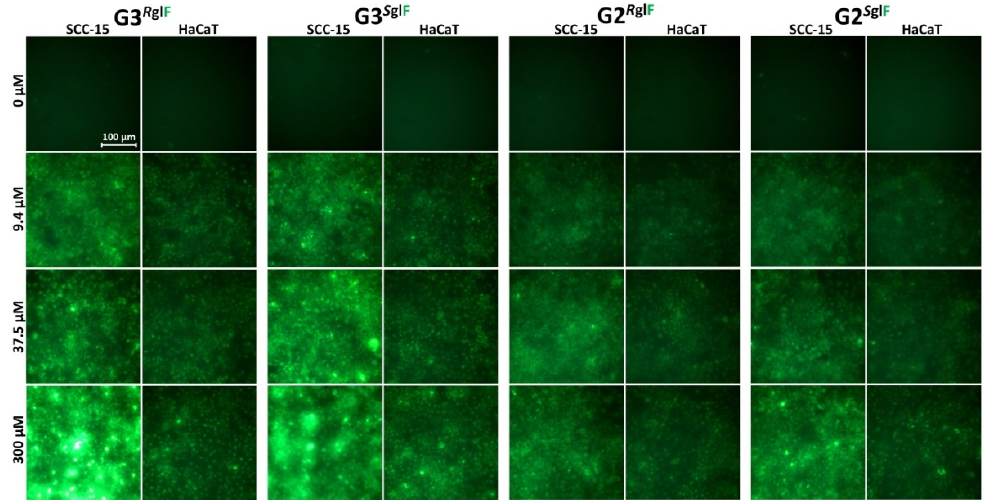
Figure 7. Concentration-dependent cellular accumulation of G3 R glF , G3 S glF , G2 R glF and G2 S glF in HaCaT and SCC-15 cells after 24 h incubation. Images were obtained with an Olympus IX-83 fluorescence microscope.